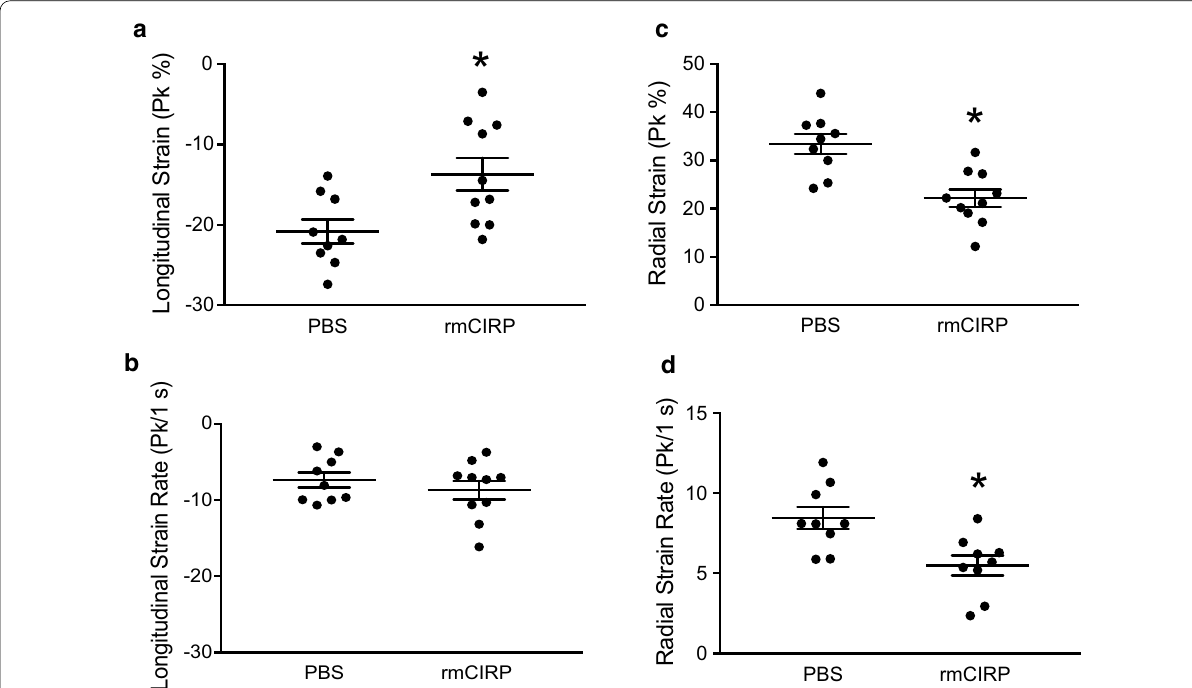
Fig. 8 rmCIRP impairs cardiac strain. In vivo rmCIRP exposures causes cardiac dysfunction as evidenced by changes in global longitudinal and radial strain and strain rate. 2 h after rmCIRP injection, mouse pups underwent echocardiogram. B modes images were analyzed using VivoStrain software. rmCIRP injection resulted in impaired a longitudinal strain and b strain rate as well as impaired c radial strain and d strain rate. Data are expressed as means SE and compared by two‑tailed student’s t test (* p < 0.05 vs PBS control; PBS ±